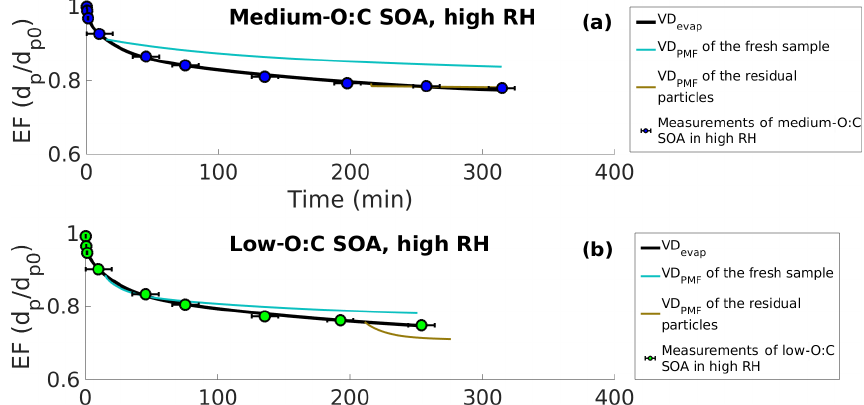
Figure 4. Evapograms of high-RH experiments showing the evaporation factors (remaining fraction of the initial particle diameter; circles) and their uncertainty in time for (a) medium-O : C SOA and (b) low-O : C SOA. Liquid-like evaporation model (LLEVAP) simulated eva- pograms calculated using the best fit VD evap (solid black lines) and LLEVAP simulated evapograms calculated with VD PMF (turquoise lines for VD PMF of fresh SOA and light brown lines for simulations with VD PMF of the residual particles evaporated for 173–259 and 168–254min for medium- and low-O : C SOAs, respectively). The evapograms calculated with the VD PMF of the fresh samples show a lower rate of evaporation than the evapogram calculated with the VD evap , which is consistent with volatility distribution shown in Fig. 3. The evapograms calculated with the VD PMF of the residual particles (the RTC sample) show a similar rate of evaporation for medium-O : C SOA and a faster rate of evaporation for low-O : C SOA compared to evapograms calculated with VD evap , which is similarly consistent with Fig. 3.